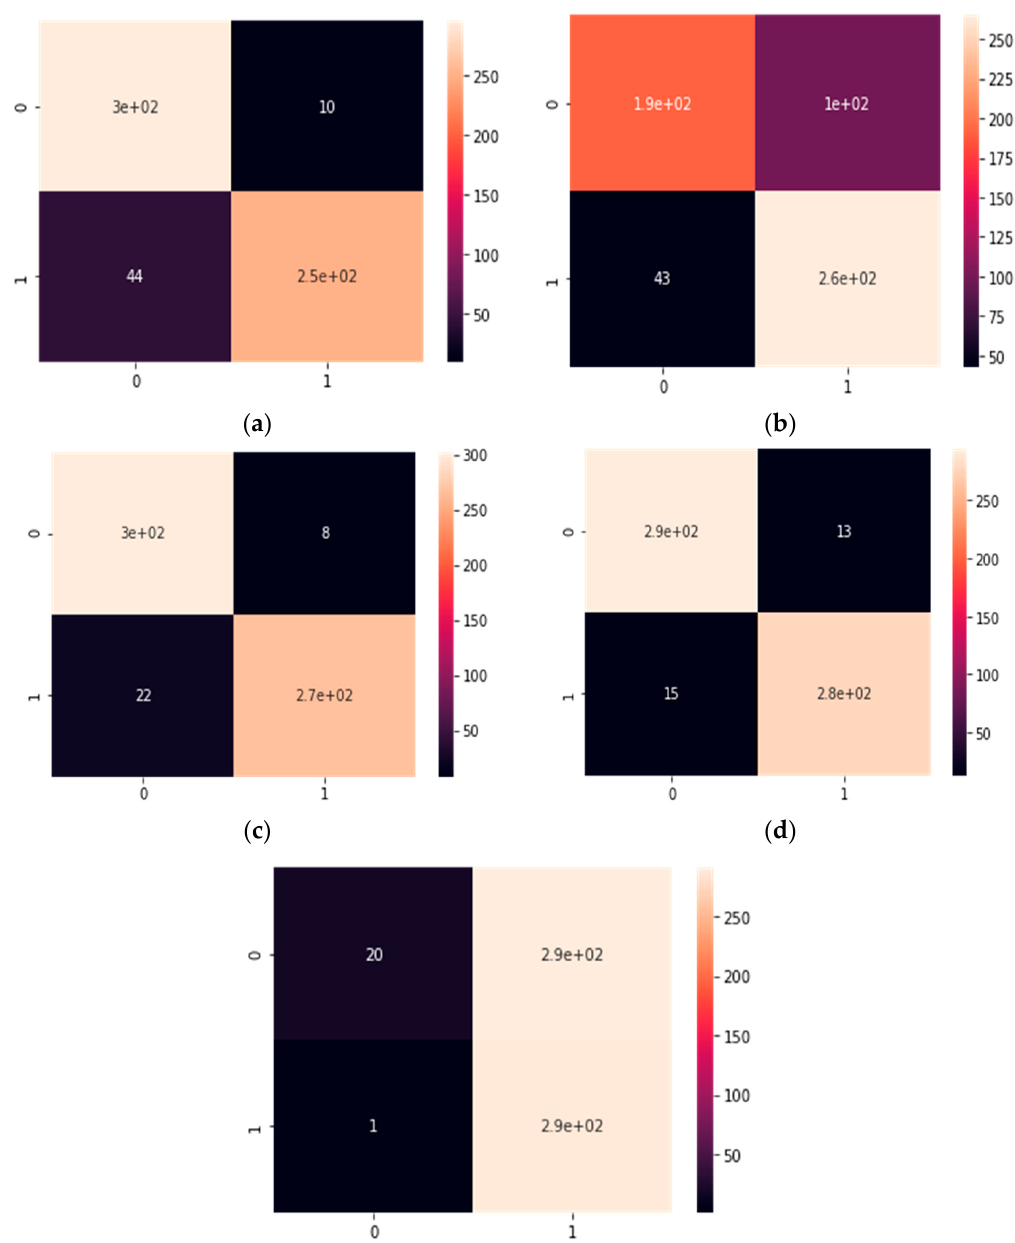
Figure 9. Confusion matrix obtained by the ( a ) 1-CNN, ( b ) 2-CNN, ( c ) 3-CNN, ( d ) 4-CNN, and ( e ) transfer learning with ResNet50 models.